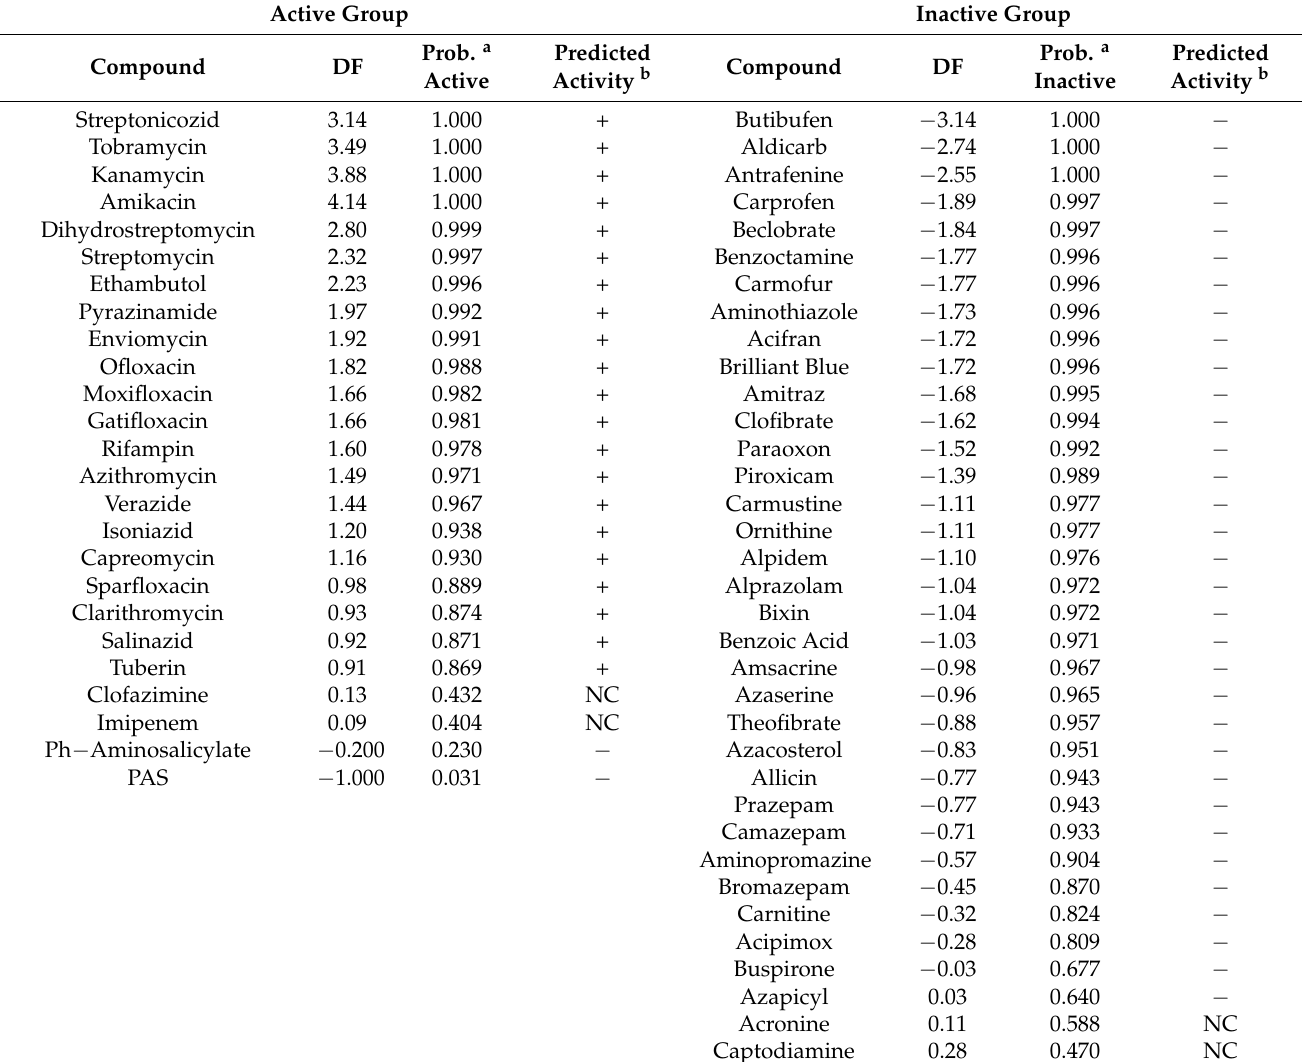
Table 2. Classification for each compound by